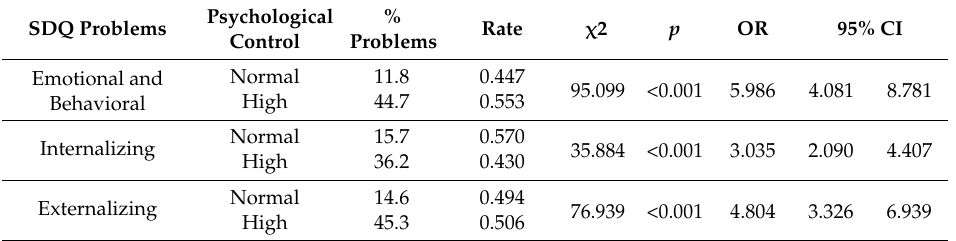
Table 2. Odds ratio according to the dependent variables under study (emotional and behavioral problems, internalizing problems, externalizing problems) and psychological